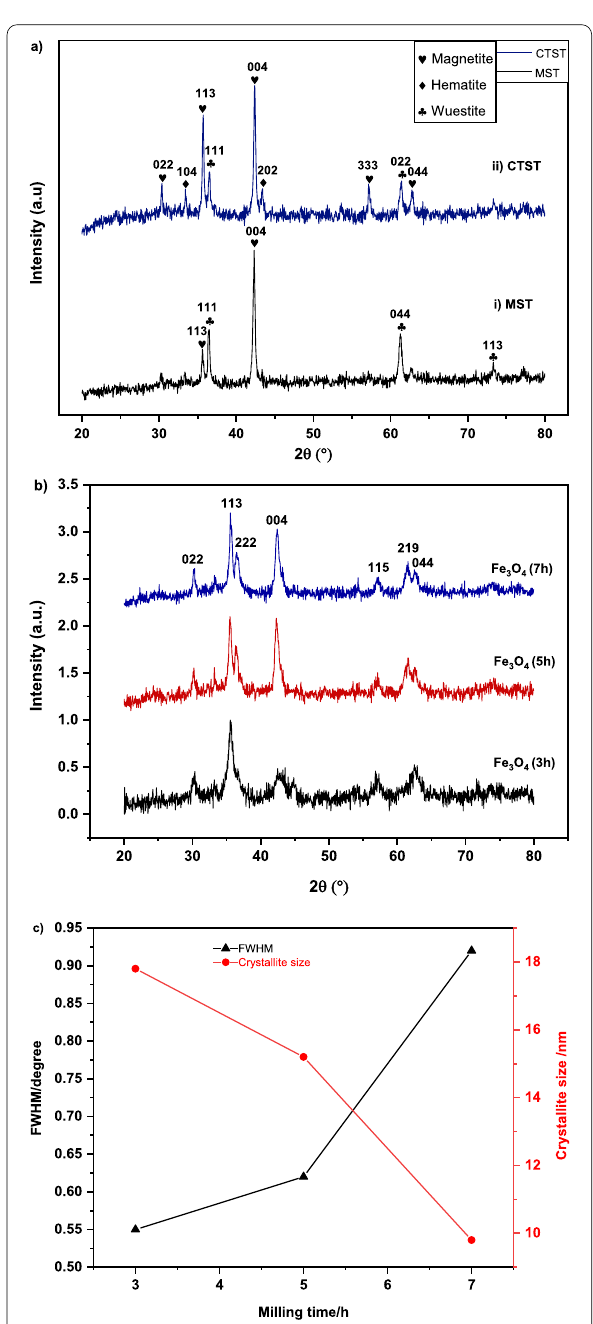
Fig. 2 a X-ray diffraction spectra of mill scale after undergoing MST and CTST, b indexed spectra of magnetite at different milling times of 3, 5, and 7 h, c The full width at half maximum (FWHM) and crystallite size of MNA with milling